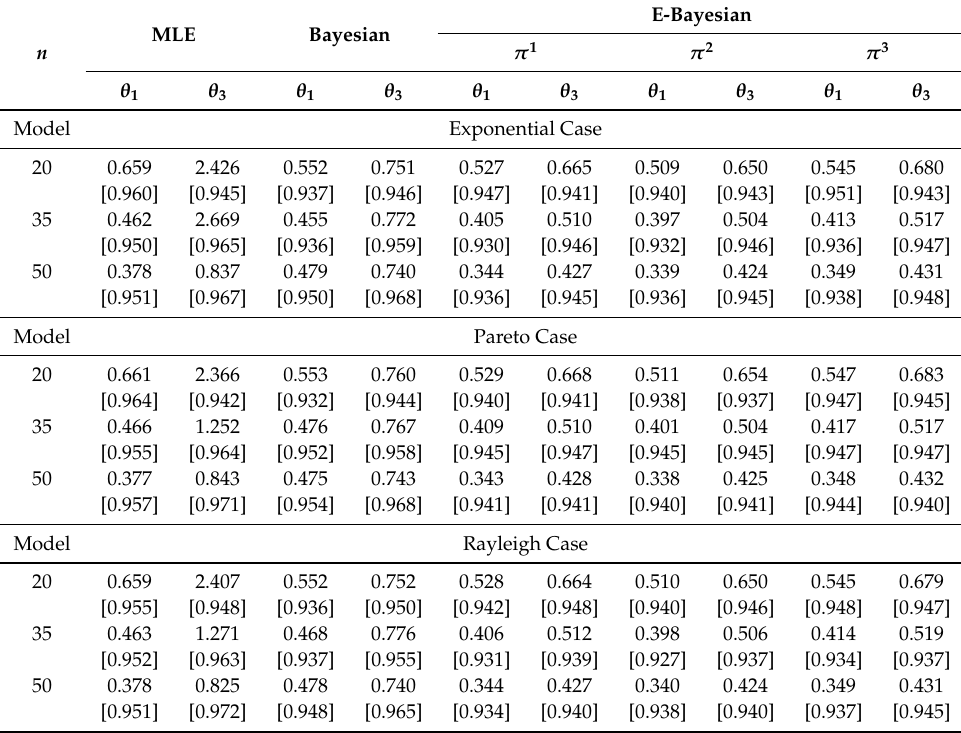
Table 7. The ALs and CPs (within bracket) of interval estimates with ( c 1 , c 2 , c 3 ) = ( 3,2.5,2 ) .